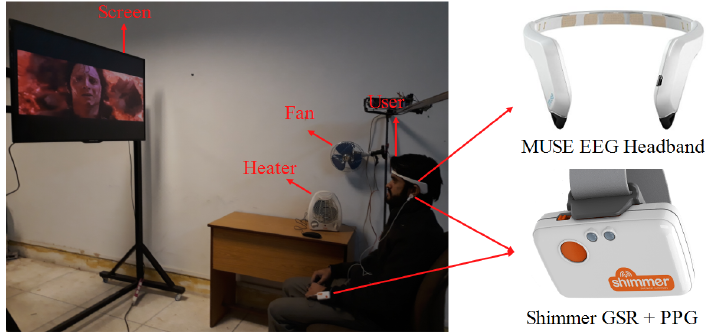
Figure 3. Experimental setup and apparatus used for data recording while watching TEM clips.